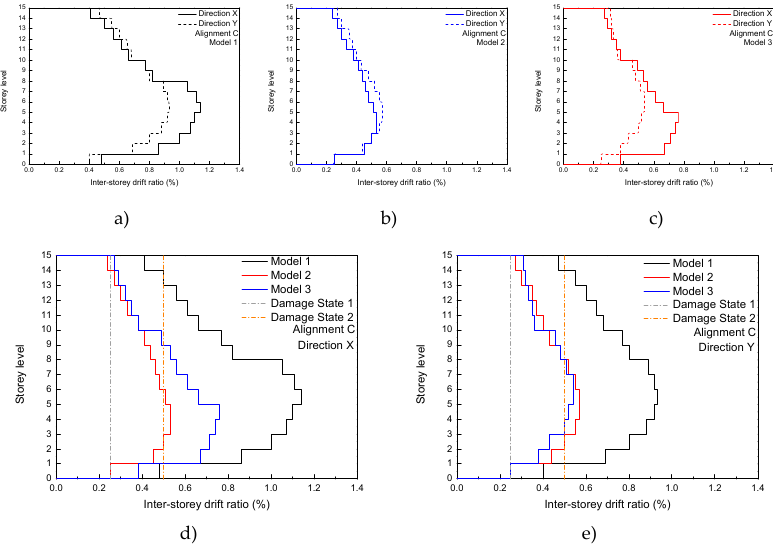
Figure 18. Linear elastic dynamic analysis result: maximum inter-storey drift ration (alignment C) ( a ) Model 1; ( b ) Model 2; ( c ) Model 3; ( d ) global comparison (Direction X); and ( e ) global comparison (direction Y).